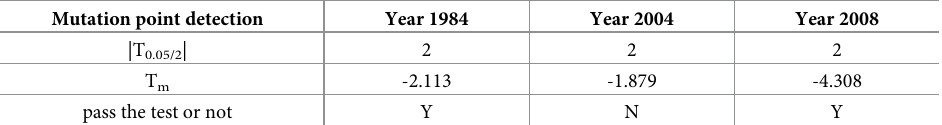
Table 1. Detection results of ApEn on annual sediment discharge at Wu Long station by sliding